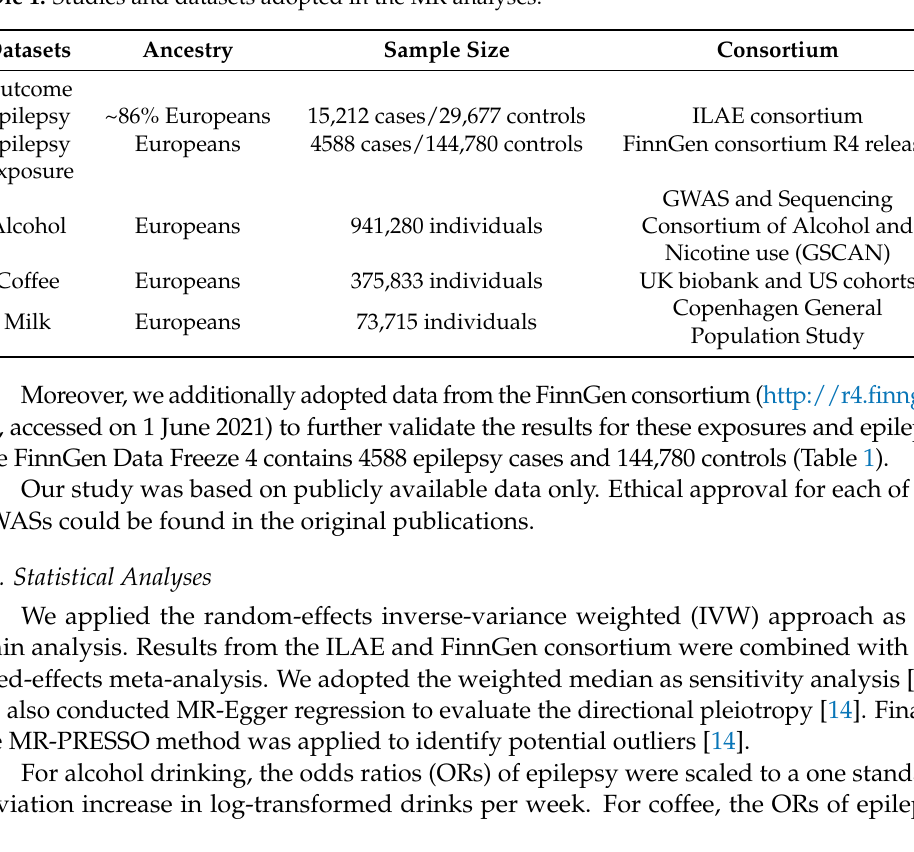
Table 1. Studies and datasets adopted in the MR